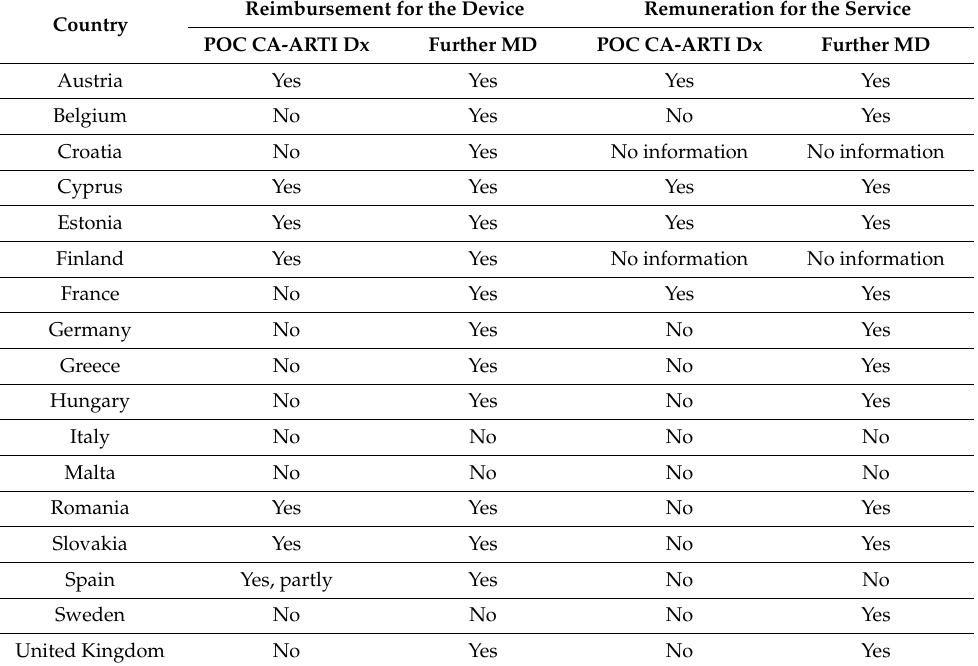
Table 3. Funding policies for CA-ARTI